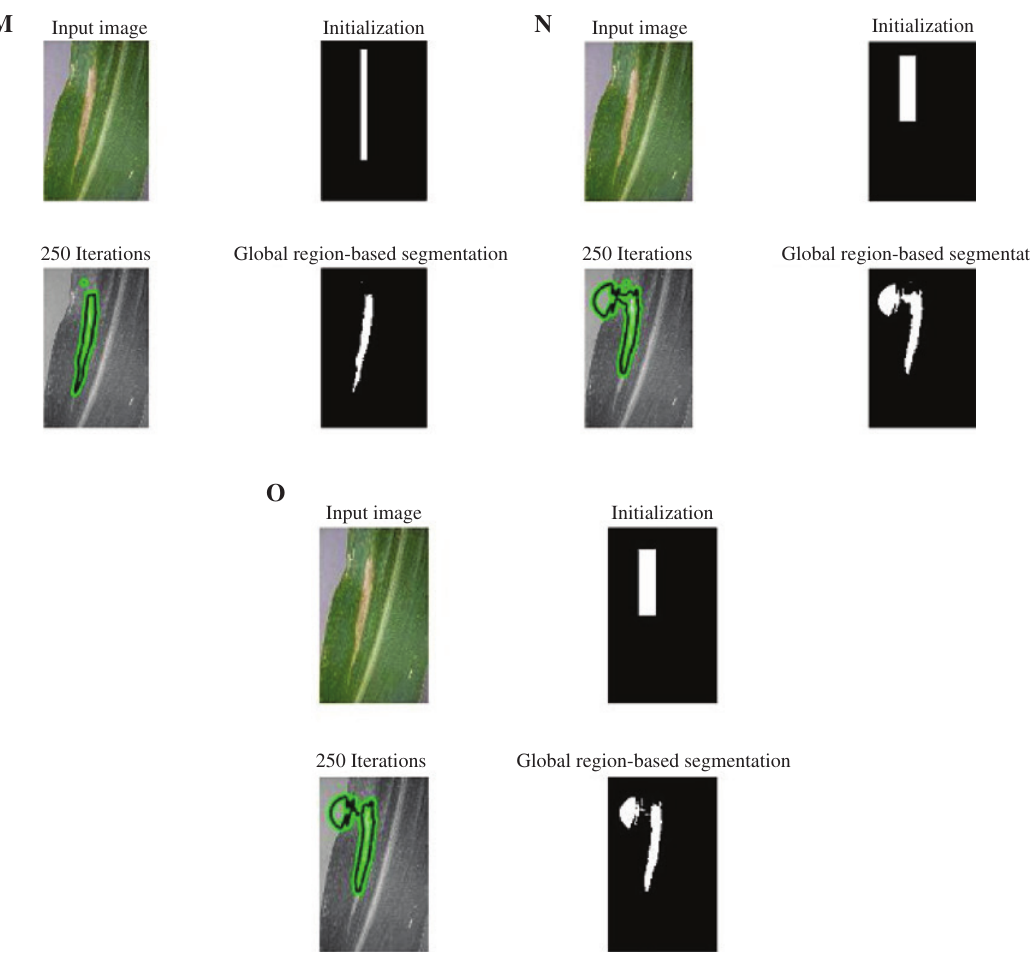
Figure 10: The Output Result of Image 18.jpg. (M) Proposed OFA-based ACM; (N) existing GA-based ACM; (O) conventional ACM.